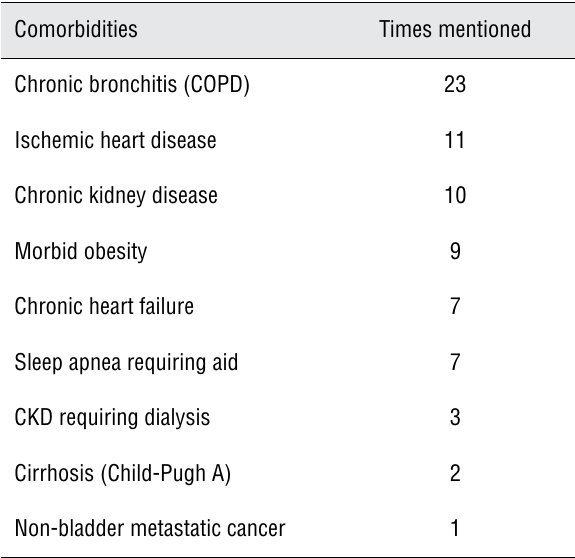
Table 2 - Major comorbidities encountered during patien-